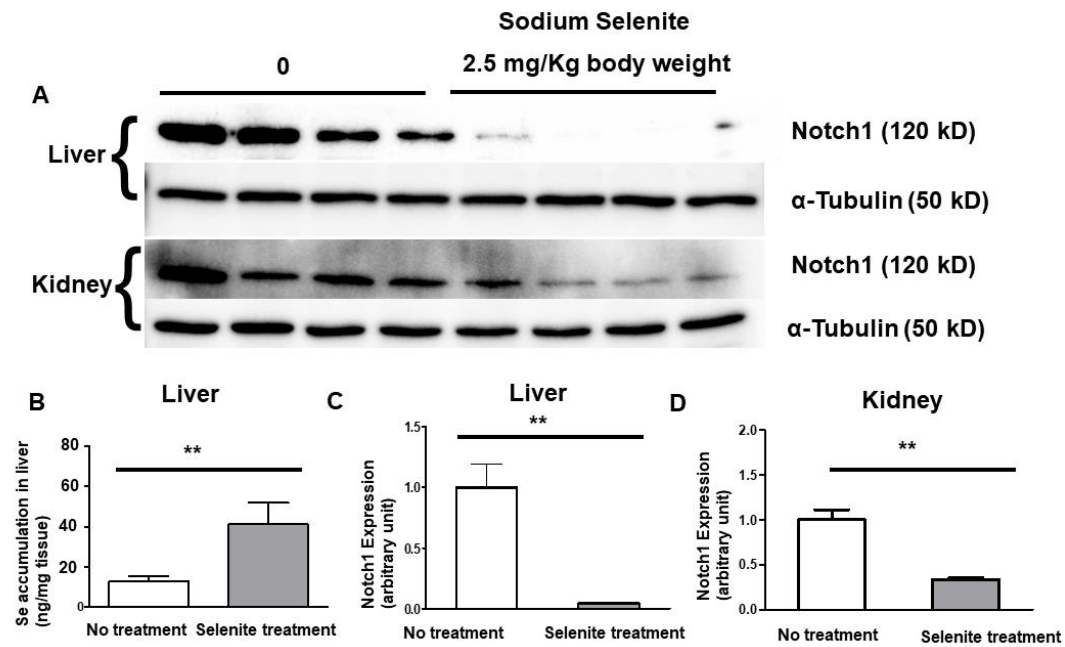
Figure 3. Selenite inhibits Notch1 expression in mouse liver and kidney. Sodium selenite was administrated via intraperi- toneal (IP) injection at a final dosage of 2.5 mg/kg for 6 h treatment. After treatment, liver and kidney tissues were collected for Notch quantification by Western blot. ( A ) Western blot of Notch1 intracellular/transmembrane region (NTM) in liver and kidney tissue homogenates. Alpha-tubulin was preferred as the loading control for all in vivo tissue samples. ( B ) Quantification of selenium in treated and non-treated mouse livers using ICP-MS to verify selenium accumulation and injection quality. n = 4 for both untreated and selenite treated wild-type mice. Western blot quantification of liver ( C ) and kidney ( D ) shows a significant decrease in Notch1 protein expression after receiving sodium selenite treatment (** p < 0.01).